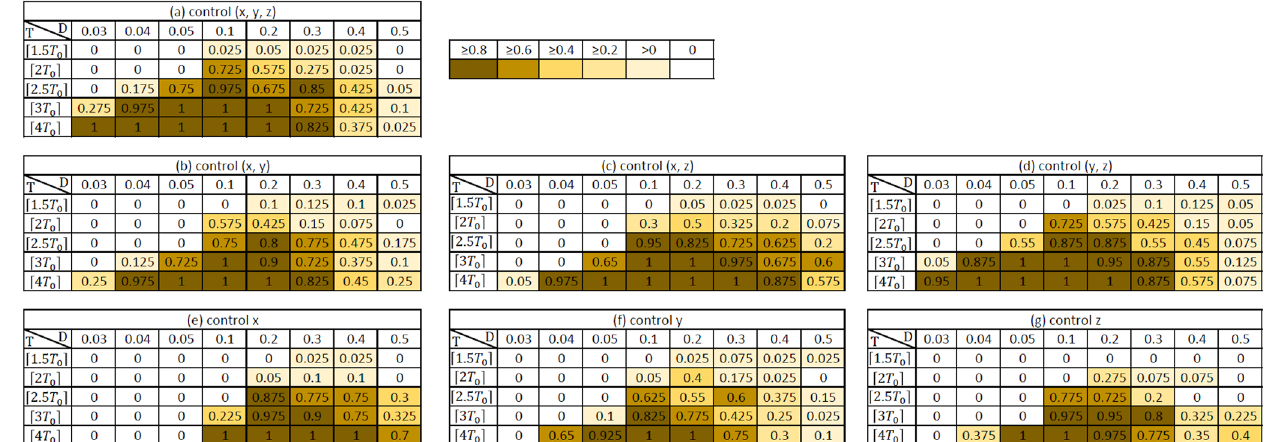
Figure B1. Similar to Fig. 3 but for the case with a longer DA interval of T a = 25.